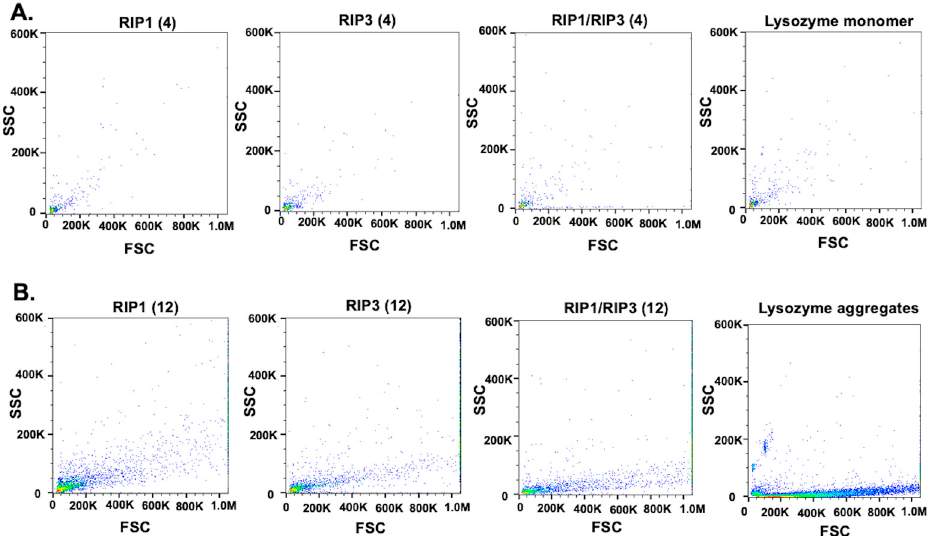
Figure 2. Peptide aggregation detection with proteostat assay. RHIM fragments were aggregated for 1 day in 100 mM ammonium acetate buffer, pH 7. Lysozyme monomers and aggregates were used as controls. ( A ) Four amino acid fragments exhibited a monomers-like scattering profile similar to lysozyme monomers. ( B ) Twelve amino acid fragments exhibited a protein aggregates-like scattering profile similar to the lysozyme aggregates .